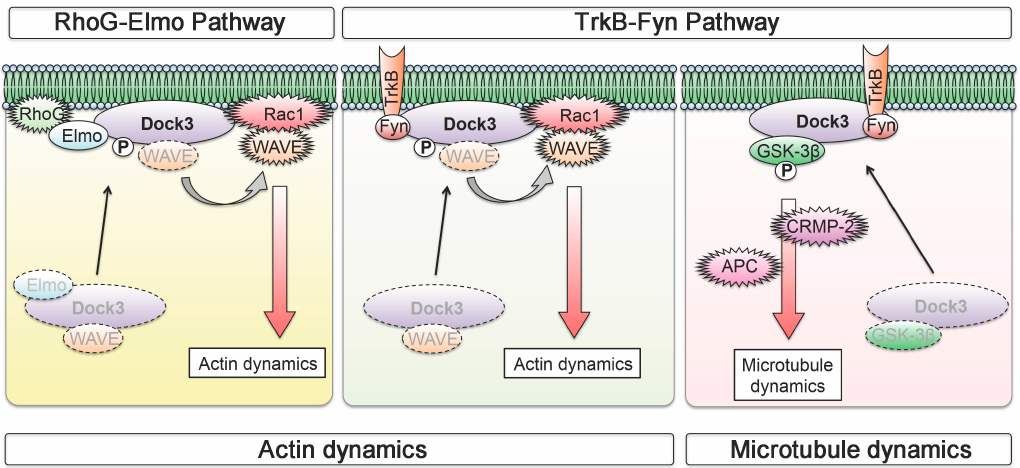
Figure 2. The Dock3 signalling pathways in optic nerve regeneration. Reproduced from Namekata et al., Prog. Retin. Eye Res. 2014, 43 , 1–16, ref. [95]. In the RhoG-Elmo pathway, Dock3 is recruited to the plasma membrane by the formation of a RhoG-Elmo-Dock3 complex, leading to translocation of WAVE and Rac1 activation. This signalling pathway stimulates actin dynamics ( left ); In the TrkB-Fyn pathway, Dock3 promotes both actin dynamics and microtubule dynamics. Recruitment of Dock3 to the plasma membrane by BDNF stimulation induces activation of Rac1/WAVE signalling and promotes actin dynamics ( middle ); GSK-3 β is translocated to the plasma membrane by Dock3, where it is inactivated, leading to stimulation of microtubule dynamics via CRMP-2 and APC ( right ).